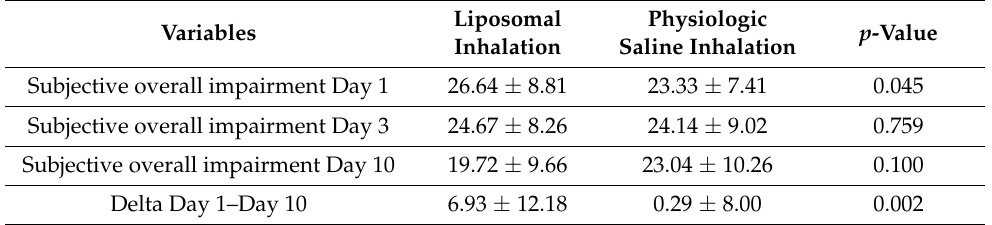
Table 5. Subjective overall impairment at Day 1, Day 3 and Day 10 after tracheostomy. Subjec- tive overall impairment: sum of the visual analogue scales of the parameter coughing frequency, breathlessness, mucous congestion, color and consistency of tracheal